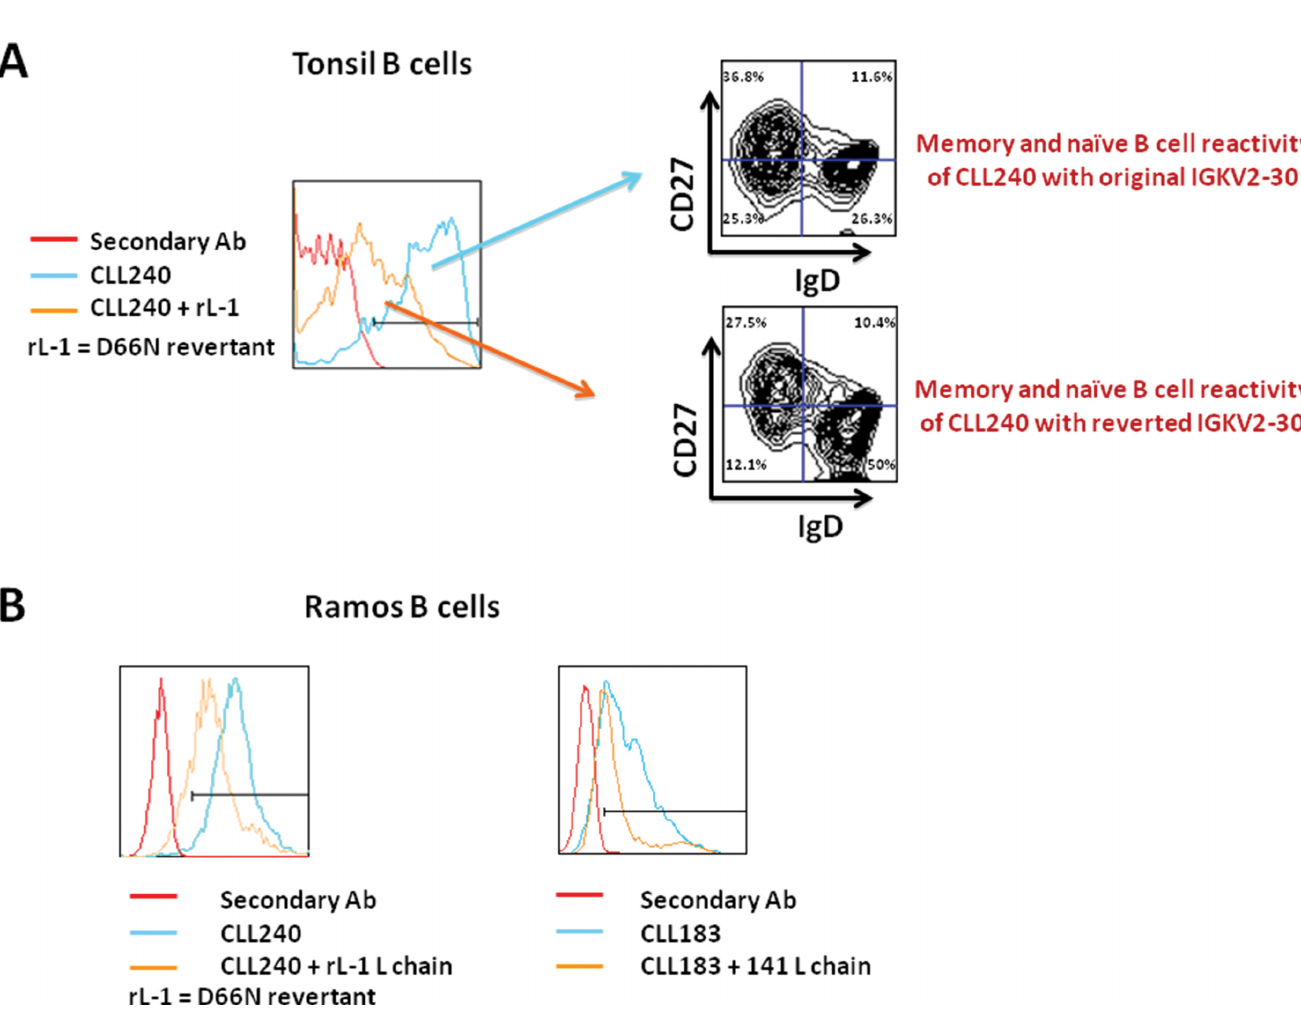
Figure 6. Effect of individual IGHV4-34 reversions on the binding of subset 4 IG 240 to viable human B cells. (A) Effect of light chain